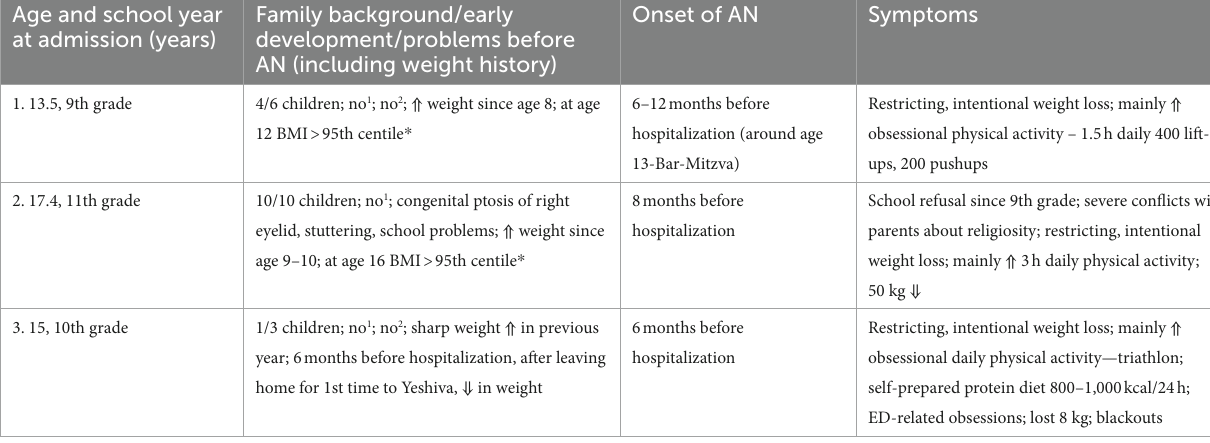
TABLE 1 Three adolescents with DSM 5-TR AN: pre-hospitalization data. Age and school year Family background/early at admission (years) development/problems